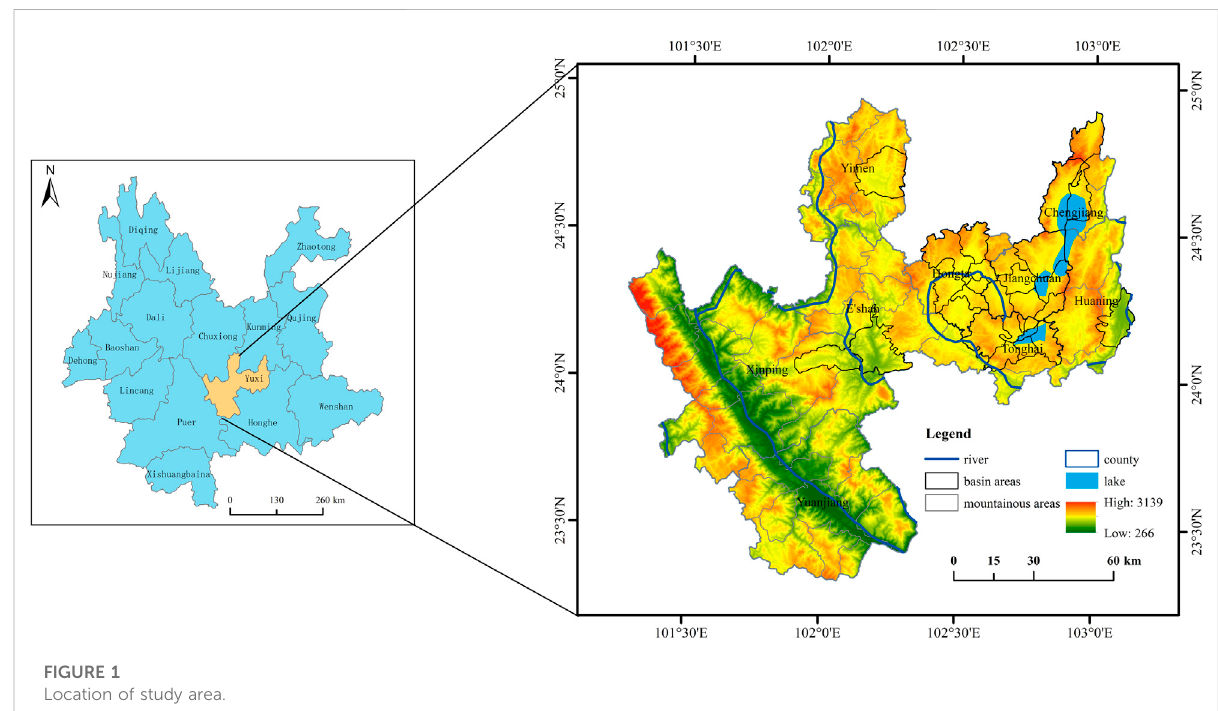
FIGURE 1 Location of study